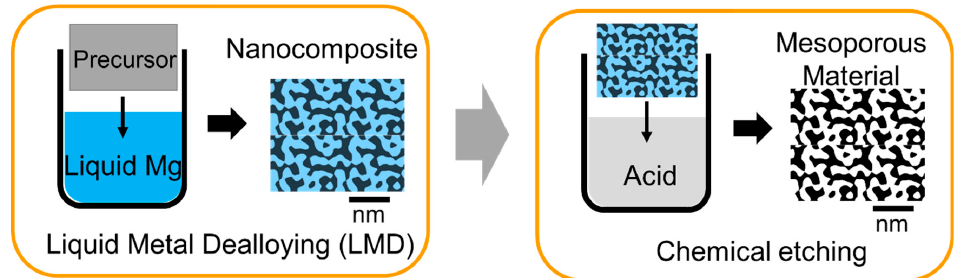
Figure 2. Schematic illustration of liquid metal dealloying process.